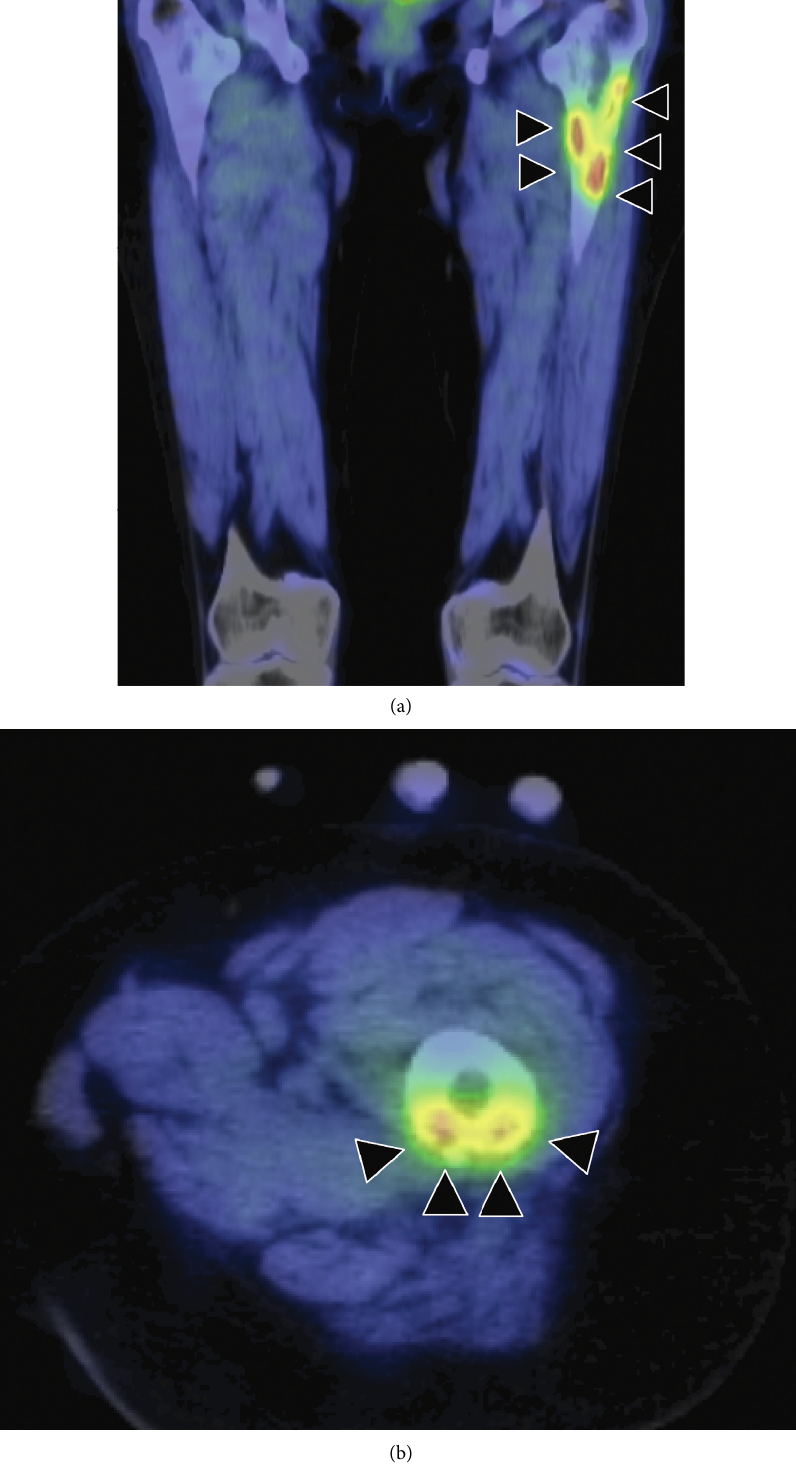
Figure 2: Whole-body PET/CT showing 18-FDG accumulations in the left femur only, suggesting a primary malignant bone tumor or chronic bacterial osteomyelitis (arrowhead). (a) Coronal view and (b) axial